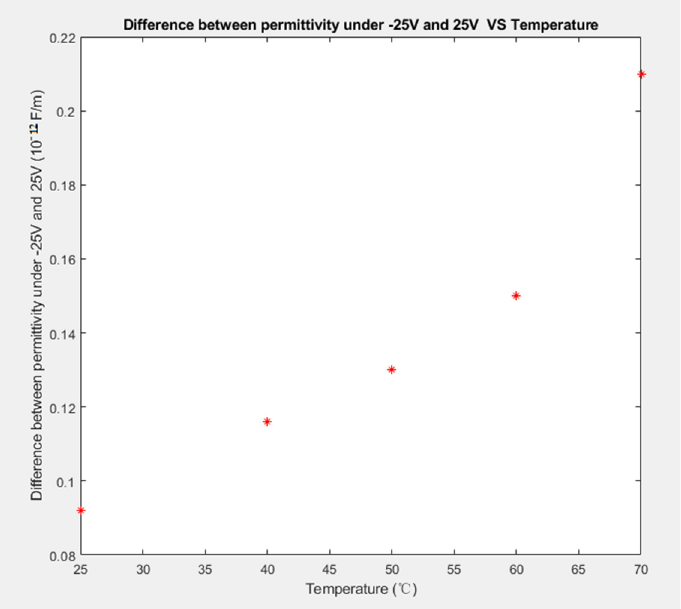
Figure 8. Difference in permittivity under applied voltages of − 25 V and 25 V vs. Temperature.